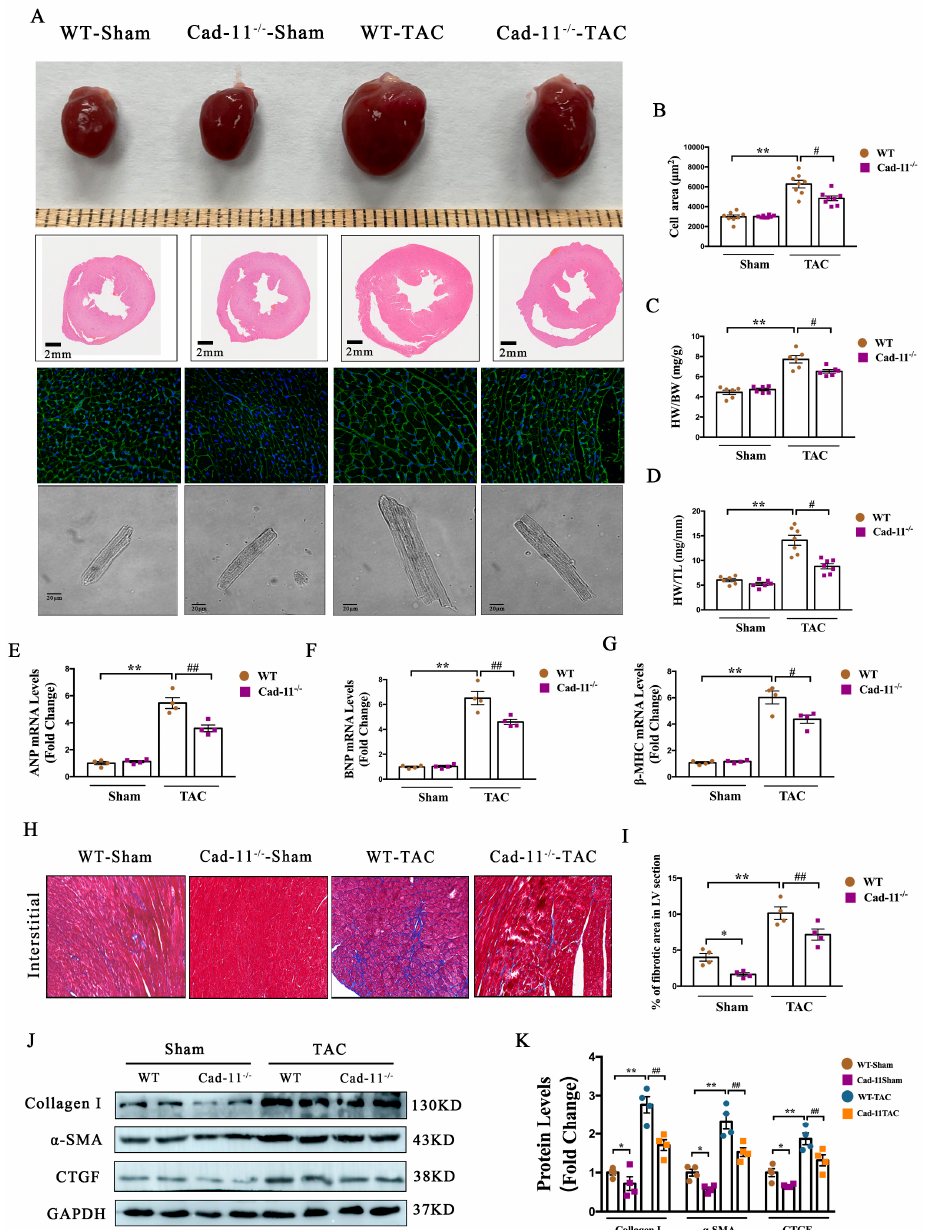
Figure 2. Loss of Cad-11 alleviated pressure overload-induced LV structural remodeling. ( A ) Repre- sentative images showing gross cardiac morphology used for heart weight/body weight (HW/BW) and heart weight/tibia length (HW/TL) calculation (top); transverse sections stained with H&E and WGA respectively (middle); Images of representative adult cardiomyocytes used for calcula- tion of cell surface area (bottom). ( B ) Quantitative assessment of myocyte cell area calculated from isolated cardiac myocytes. ( C , D ) The ratio of heart weight/body vs. weight or heart weight/tibia vs. length were calculated from WT and Cad-11-knockout mice (KO) after sham or TAC operation. ( E – G ) Expression levels of cardiac hypertrophy–related genes ANP, BNP, and β -MHC were measured using quantitative reverse transcription polymerase chain reaction from heart samples of Sham- or TAC-mice 4 weeks after surgery. ( H ) Masson trichrome staining of representative heart sections from wild-type (WT) or Cad-11 − / − mice after sham or TAC operation. ( I ) Statistical analysis of differences in cardiac fibrosis. ( n = 4 in each group). ( J , K ) Protein levels of fibrosis genes in the hearts from indicated mice determined by Western blotting. ( n = 4 in each group). Data were presented as mean ± SEM, * p < 0.05, ** p < 0.01 vs. WT-Sham group. # p < 0.05, ## p < 0.01 vs. WT-TAC